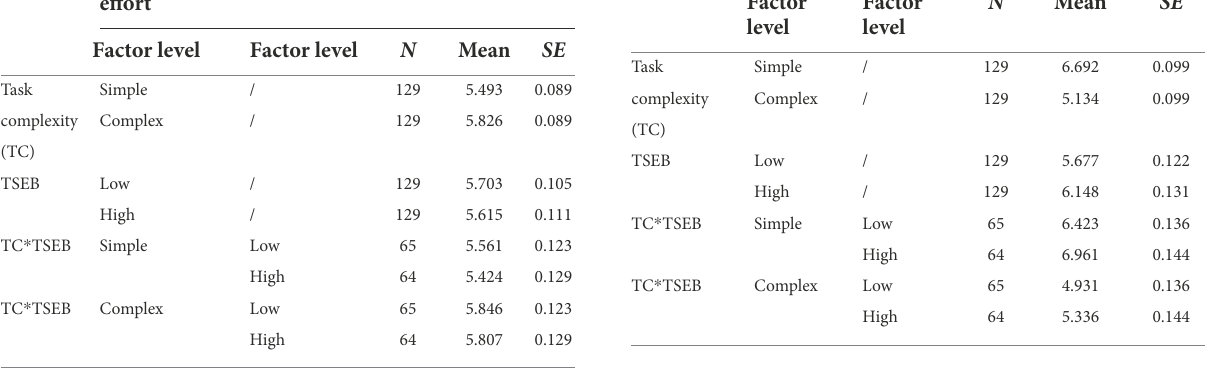
TABLE 6 Accuracy—significant effects of task complexity and